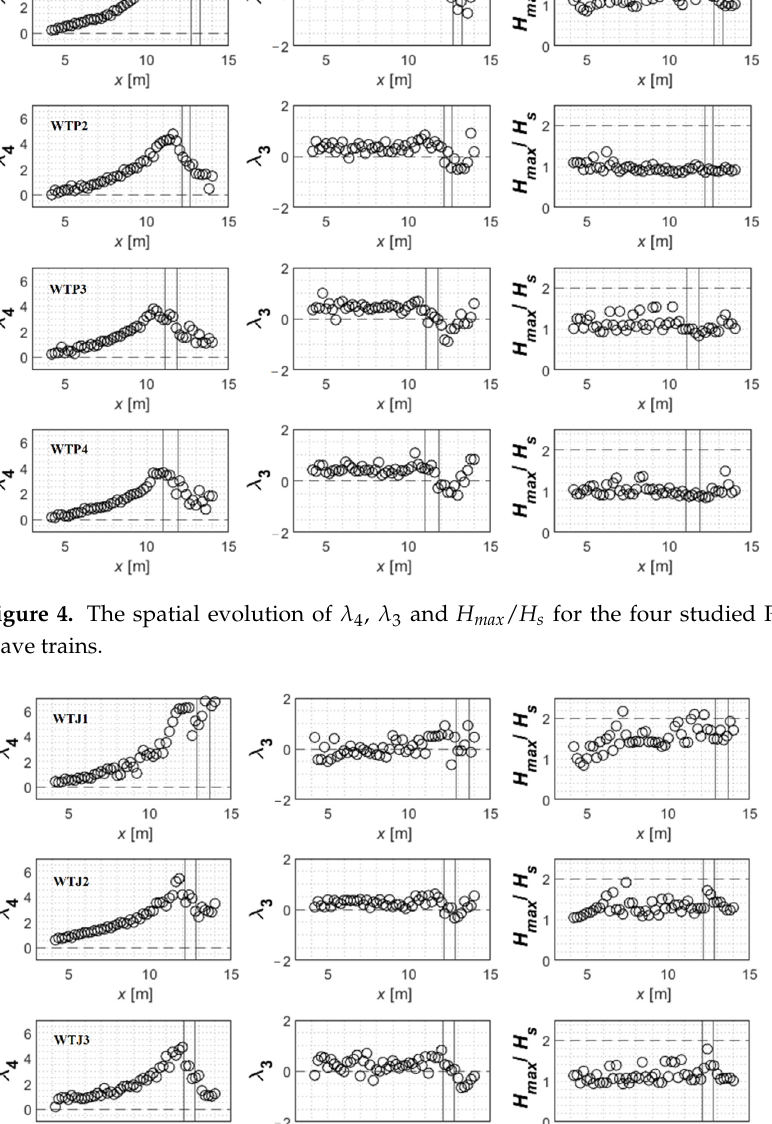
Figure 4. The spatial evolution of λ 4 , λ 3 and H max / H s for the four studied Pierson–Moskowitz wave trains.